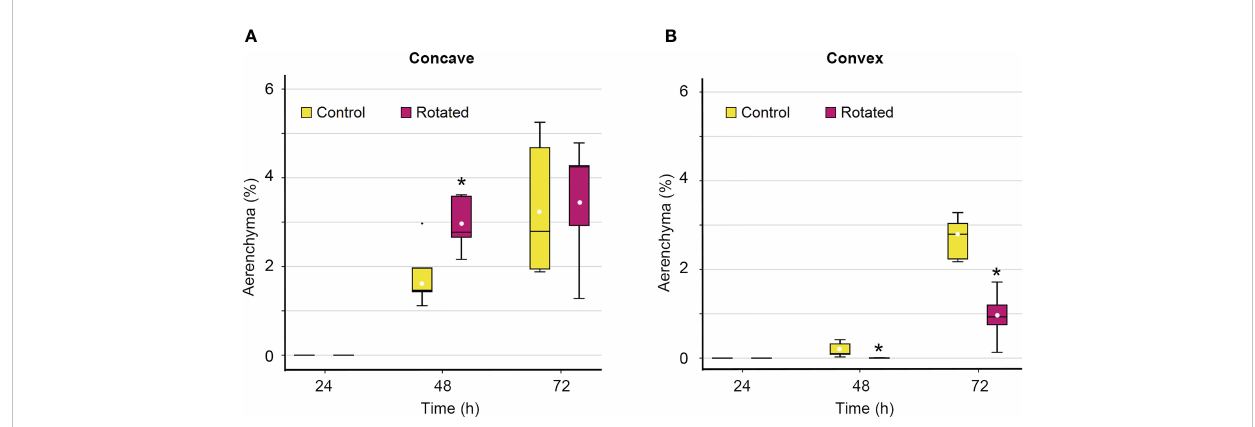
FIGURE 5 Time-course of aerenchyma formation in the cortex on the concave and convex sides in the bent region (0 mm ± 2 mm) of the gravity-stimulated nodal roots of Z. nicaraguensis . Percentage of aerenchyma formed on the concave side (A) and convex side (B) of the nodal roots at 24, 48, and 72 h after the initiation of the treatment. Boxplots show the median (horizontal lines), 25 th to 75 th percentiles (edge of the boxes), minimum to maximum (edge of the whiskers), and mean values (dots in the boxes) ( n = 5). Signi fi cant differences between the control and rotated nodal roots at p < 0.05 (two-sample t- test) are denoted with